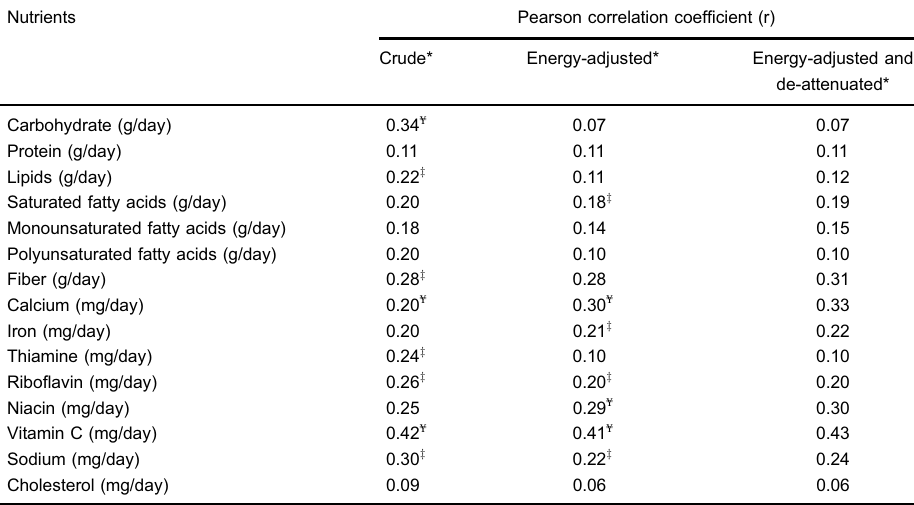
Table 2. Correlation between nutrient intake measured with the 24-hour recalls and the food frequency questionnaire. Nutrients Pearson correlation coef fi cient (r)